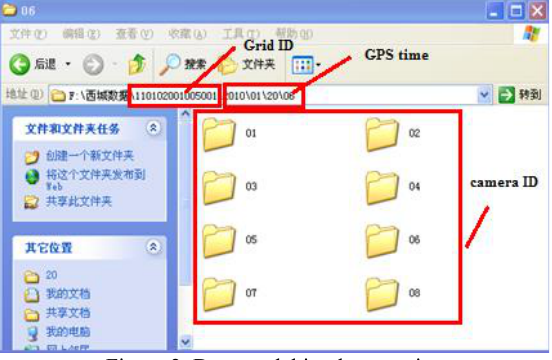
Figure 2. Data model